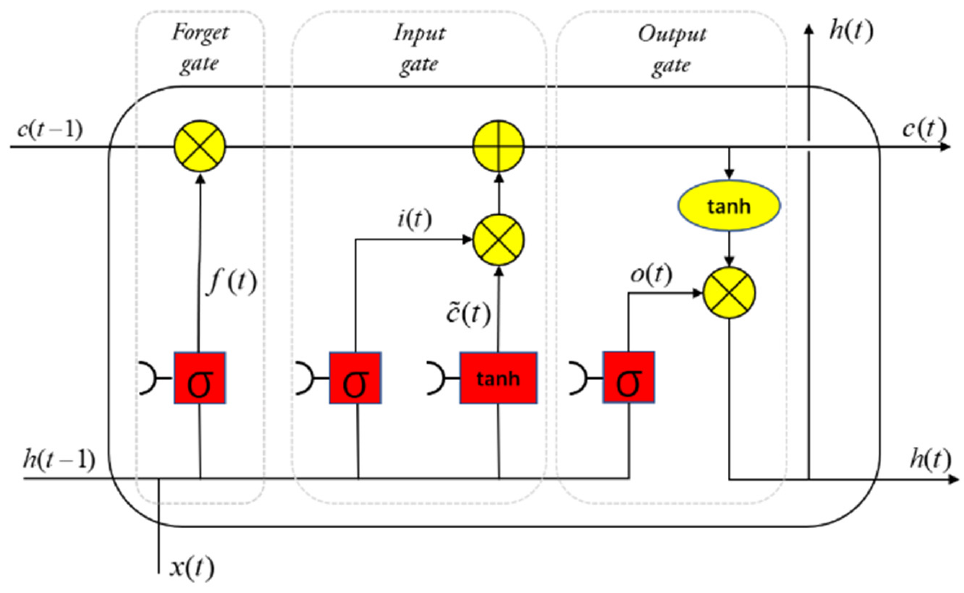
where x t , h t , and c t represent the input, the recurrent information, and the cell state at time t, respectively; f t , i t , and o t represent the forget gate, the input gate, and the output gate, b o are the biases. Figure 2 shows the LSTM architecture with a forget gate.